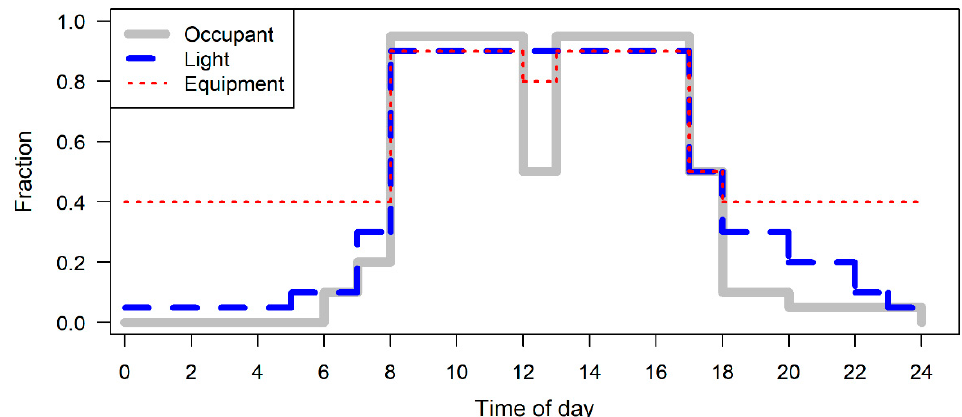
Figure 2. Hourly fraction schedules of internal heat gains including occupants, lights, and electric equipment during weekdays. The fraction of 1.0 indicates the full intensity for each internal heat gain which is provided in Table 3.